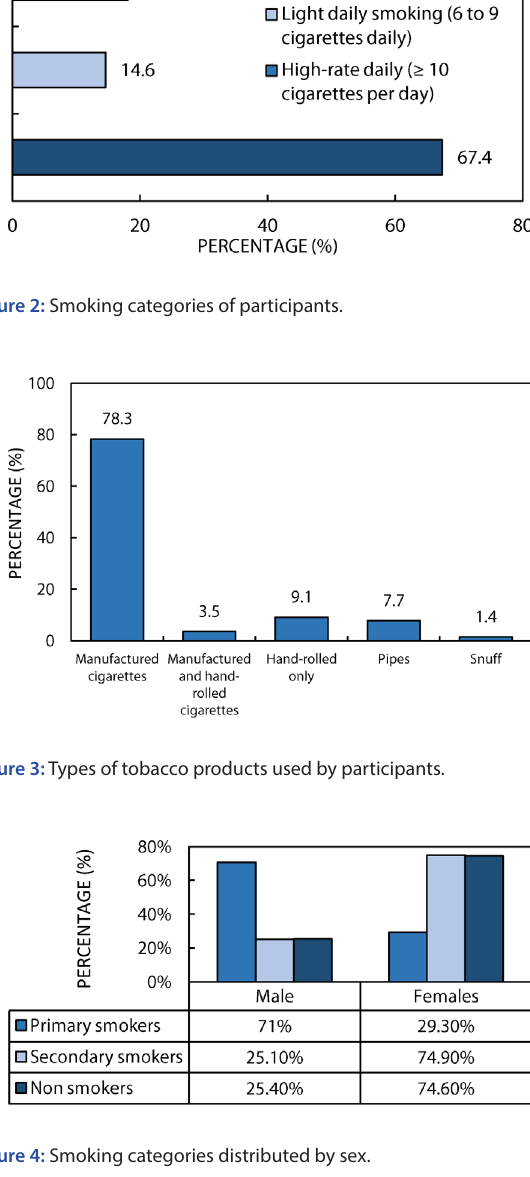
Figure 4: Smoking categories distributed by